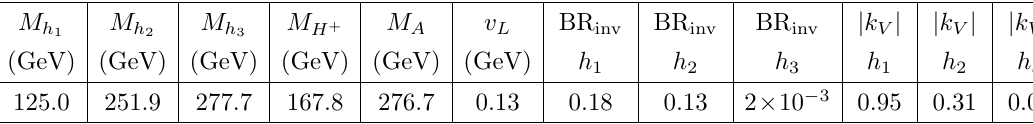
Table 5 . Parameters for point